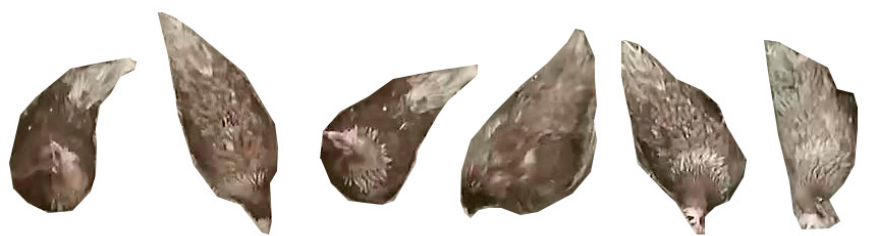
Figure 9. Sample pictures of questionable birds. The birds were manually cropped from original images. They were not labeled as preening birds and used for model development.